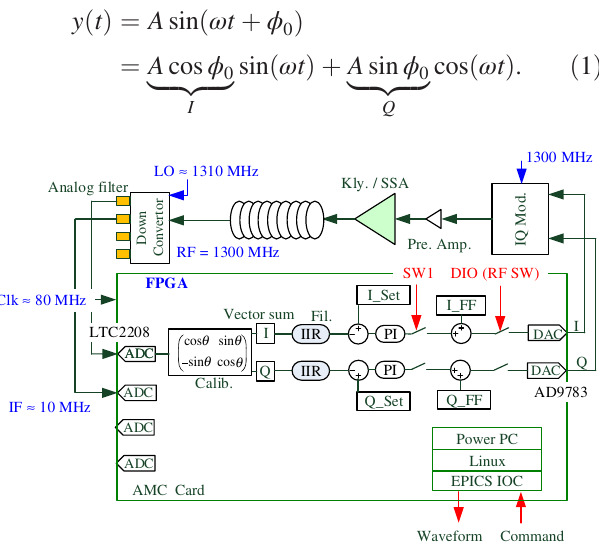
FIG. 2. LLRF system diagram in the cERL at KEK. SW1 marked in the figure provides the hand-off between the FF and FB operations.